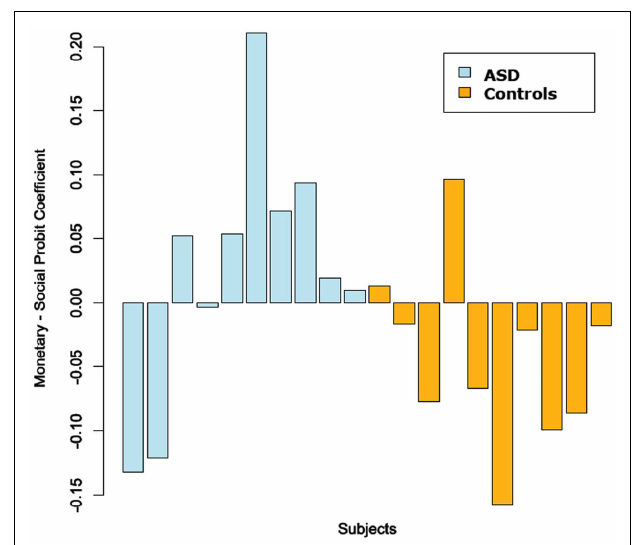
FIGURE 6 | Difference between monetary and social probit regression coefficients (positive trials only). We fit probit regressions to each subject’s choices on the positive trials in each condition.We then plotted the difference between the fitted monetary and social coefficient for each